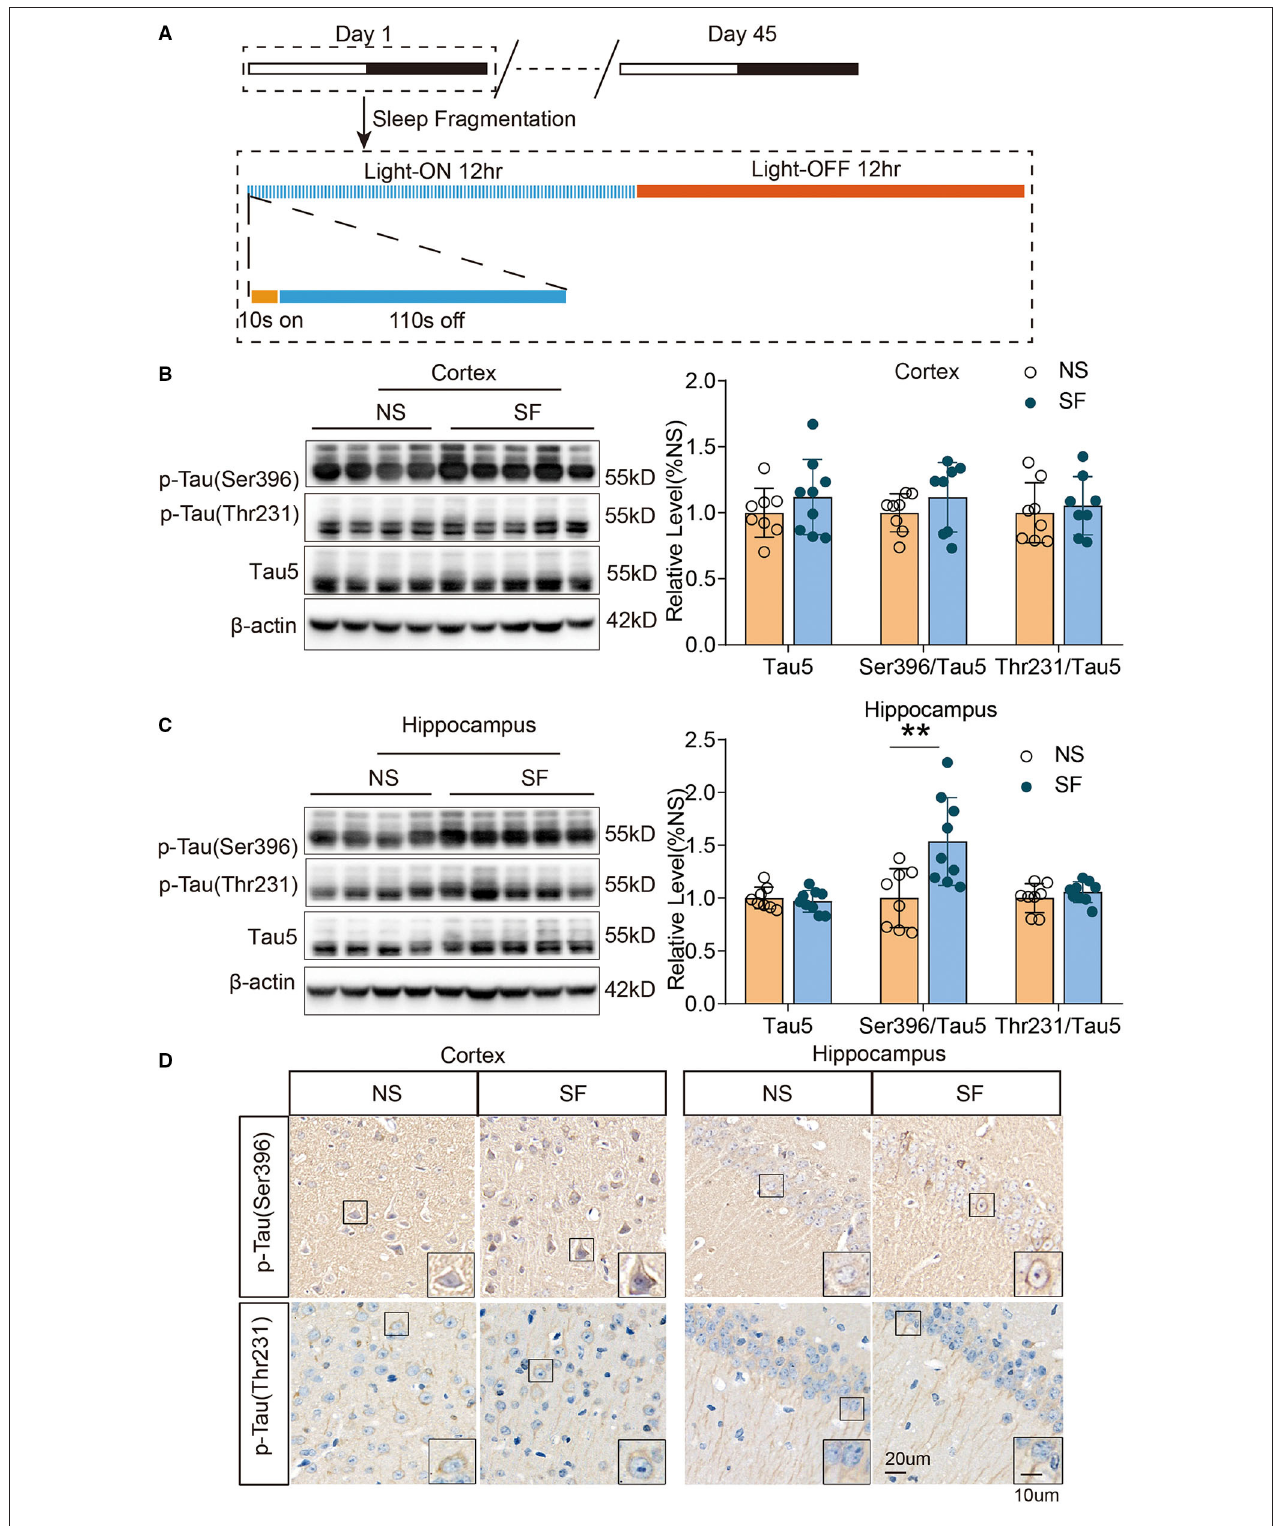
FIGURE 1 | Chronic SF increases pathologically phosphorylated tau (Ser396) in young wild-type mice hippocampus. (A) The schematic figure of the experimental design procedure, indicating the timing of the SF model. (B,C) Western blotting and quantitative density of expression of p-tau Ser396, p-tau Thr231, and tau5 in the cortex (B) and hippocampus (C) show an increase of p-tau Ser396 in SF hippocampus. β -actin was used as loading control. (D) Representative immunohistochemistry images of phosphorylated tau (p-tau Ser396 and p-tau Thr231) in the cortex and hippocampus of SF and NS group. Scale Bar = 20 µ m. Local enlarged images were presented in the boxes. Scale Bar = 10 µ m. n = 8 for NS and n = 9 for SF group. ** P < 0.01.